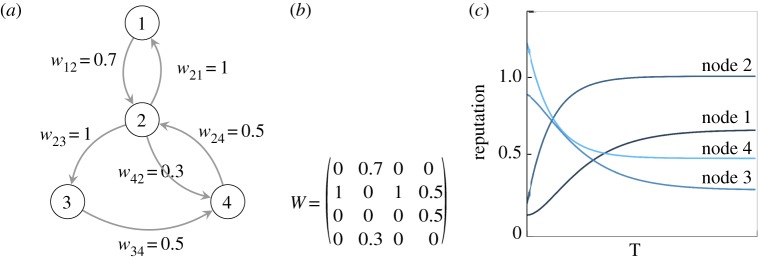
(a) Ownership network of four firms and (b) the corresponding weighted matrix W reflecting their ownership shares. (c) Numerical calculation of the reputation dynamics, to confirm the equilibrium values obtained analytically.